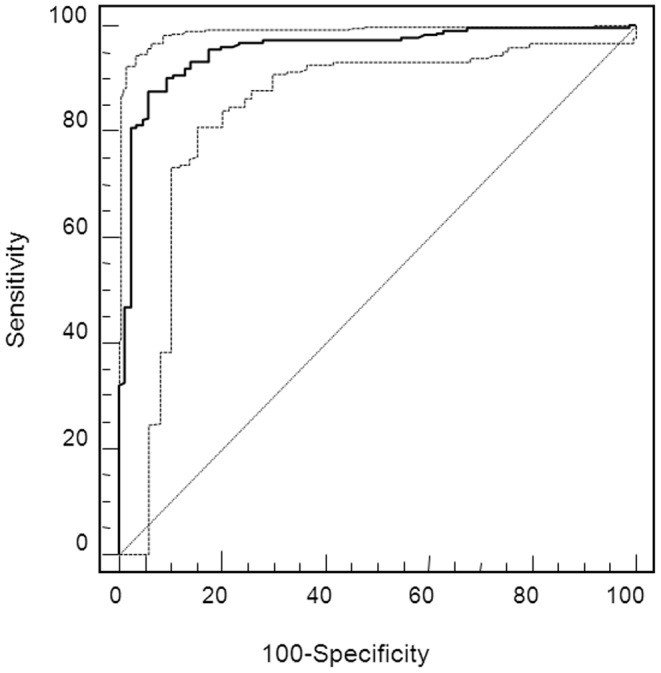
ROC curve with 95% CI for the differentiation of ADPKD patients from healthy controls by the biomarker model ADPKD_142 applied to the CRISP validation cohort and 86 healthy individuals.